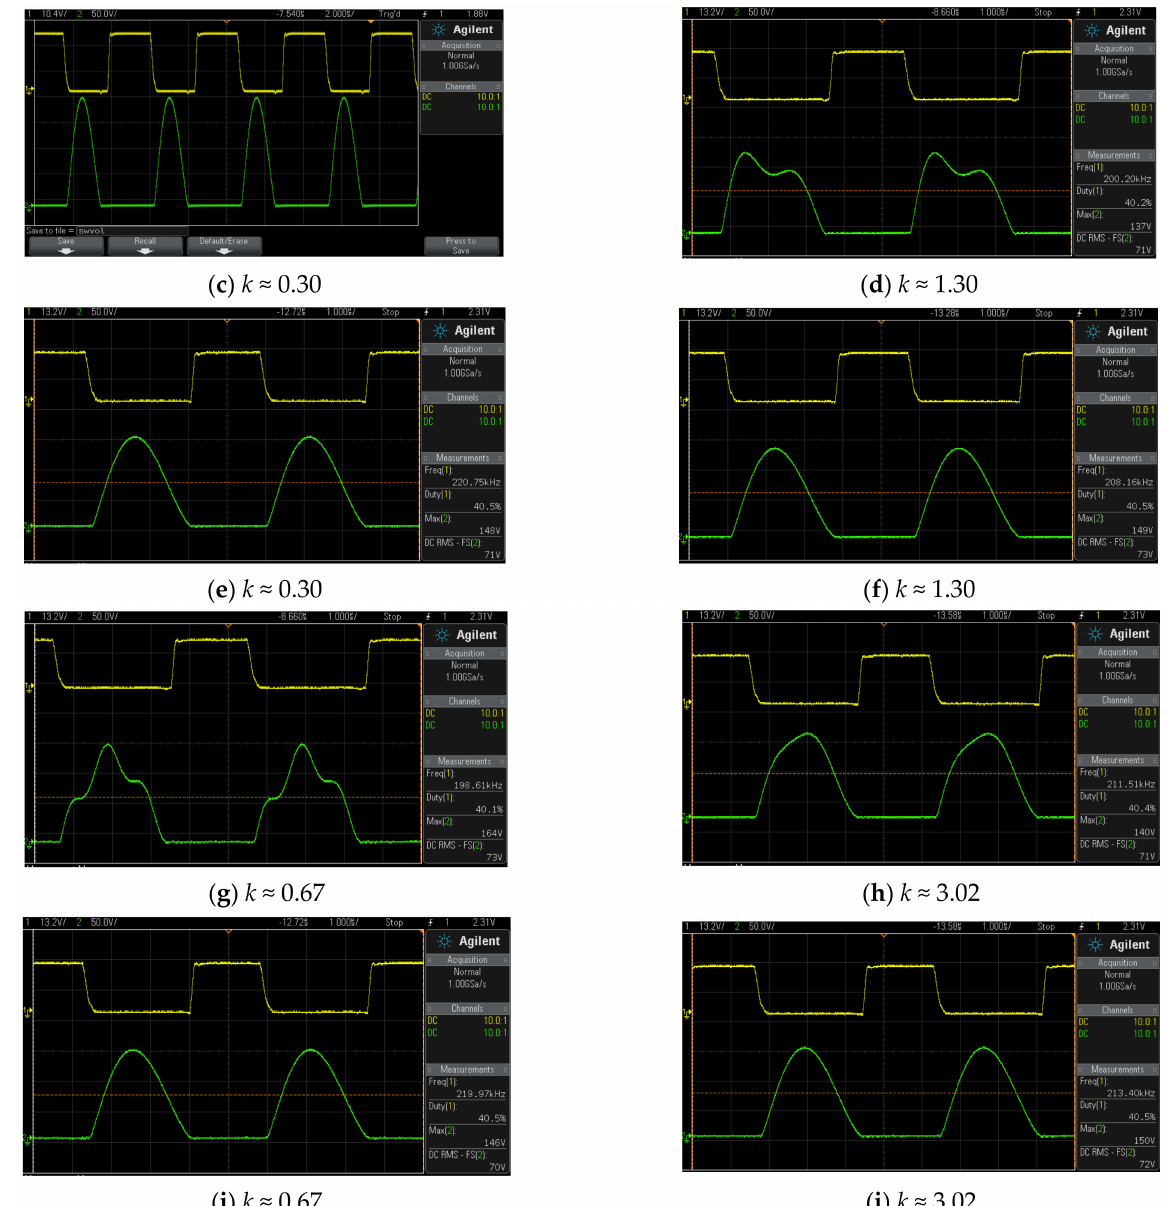
Figure 5. Class E: ( a ) V S 1 ; Class E FT : ( b ) V S 1 ; Class EF 2 : ( c ) V S 1 (s LC pLN), ( d ) V S 1 (s LC pLN), ( e ) V S 1 (p LC sLN), ( f ) V S 1 (p LC sLN); Class EF 3 : ( g ) V S 1 (s LC pLN), ( h ) V S 1 (s LC pLN), ( i ) V S 1 (p LC sLN), ( j ) V S 1 (p LC sLN) at f s ≈ 220 kHz, k ≈ 0.30,1.30 (EF 2 ) and 0.67,3.02 (E/F 3